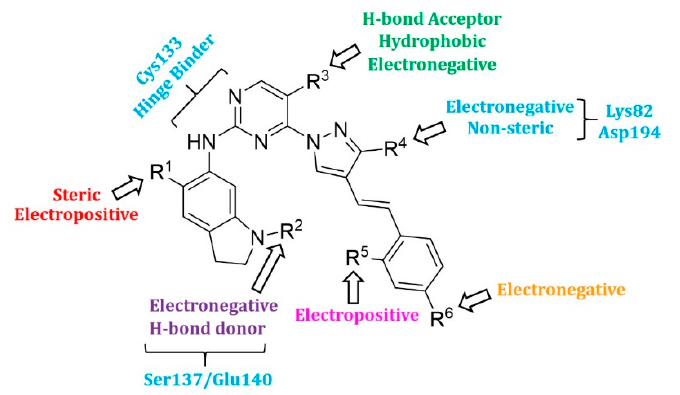
Figure 8. The design strategy for PLK1 inhibitors obtained from hybrid 3D-QSAR models.